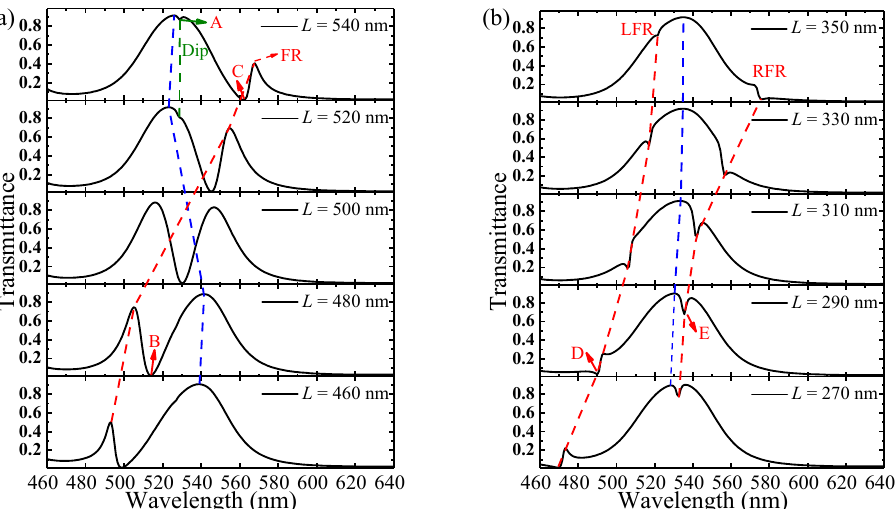
Figure 4. Transmission spectrums for different values of rectangle resonator length L : ( a ) L = 460, 480, 500, 520, and 540 nm, ( b ) L = 270, 290, 310, 330, and 350 nm. Meanwhile, t o deeply understand the physics mechanism of these Fano resonances , Figure 5a–c give the Hz field distributions at the Fano resonance valleys of points ‘A’–‘E’ in Figure 4a,b, respectively.